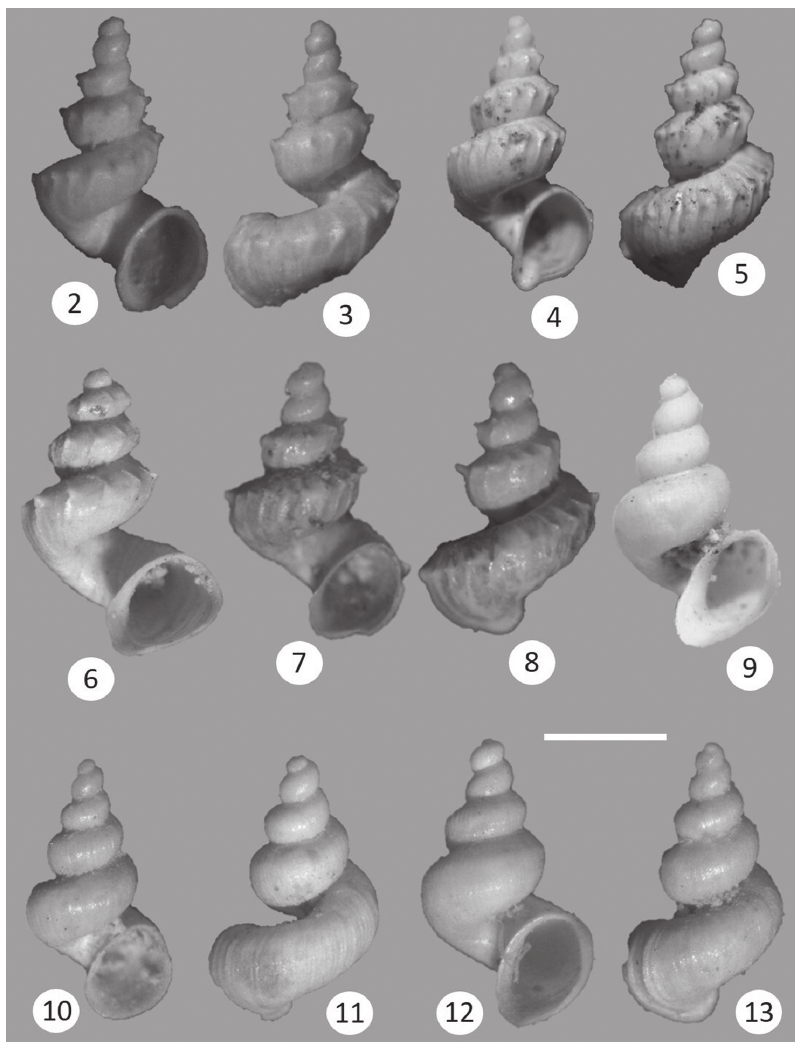
Figures 2–13. Shells of Phreatoviesca spinosa gen. nov. et sp. nov. 2 , 3 holotype, specimen from both sides, UJMC 500 4 , 5 paratype 1, specimen from both sides, UJMC 501 6 paratype 2, specimen with a ‘corkscrew’- like morphology, UJMC 502 7 , 8 paratype 3, specimen from both sides, UJMC 503 9 paratype 4, specimen with smooth whorls and a trumpet-like aperture, UJMC 504 10 , 11 paratype 5, specimen with smooth whorls, UJMC 505. Opercula 12 , 13 paratype 5, specimen with smooth whorls, UJMC 505. Scale bar: 1 mm. Types. Holotype (Figs 2, 3), UJMC 500, from type locality, leg. A. Czaja, 15/v/2019. Paratypes, UJMC 501-511, from same lot, >100 dry shells. Etymology. Name is derived from the Latin word spinosa = having